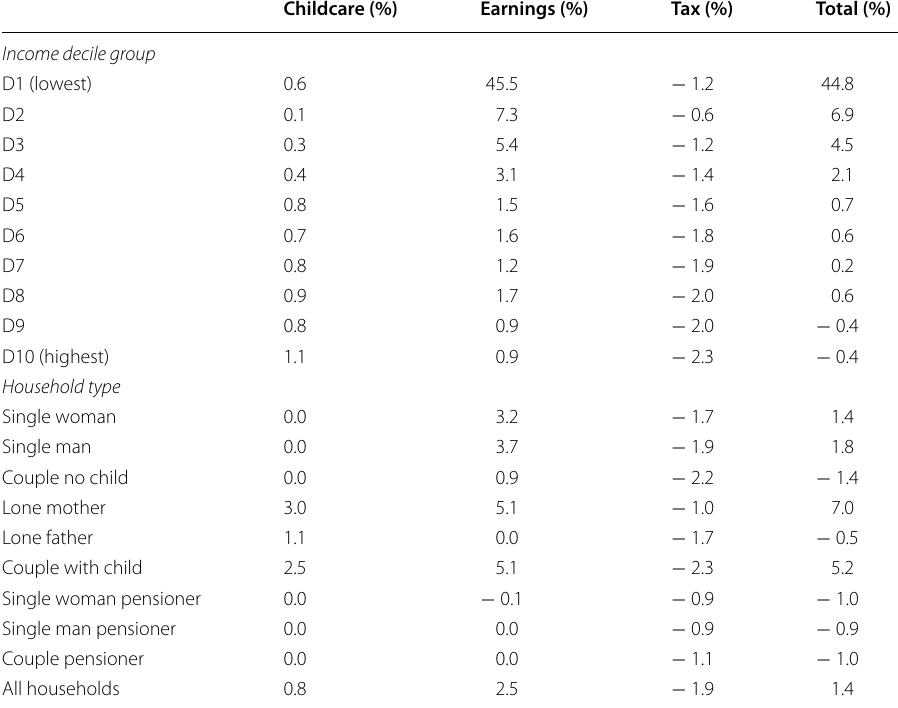
Table 10 Distributional results by decile group and household type for Scenario